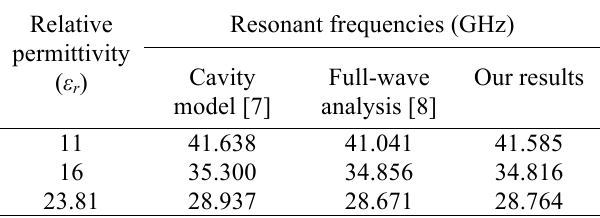
Table 1: Comparison of our calculated resonant frequencies with previously published data.